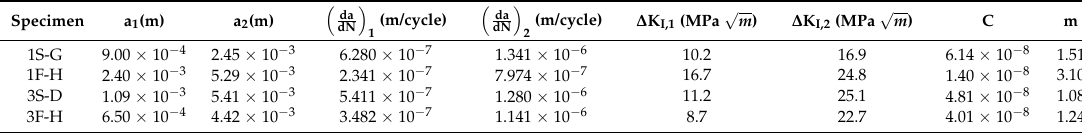
Table 8. Summary of the parameters calculation of Paris expression for several